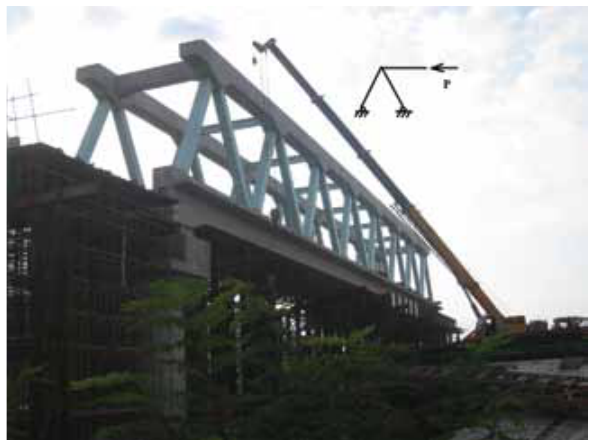
Fig. 1. Steel structure of composite truss bridge